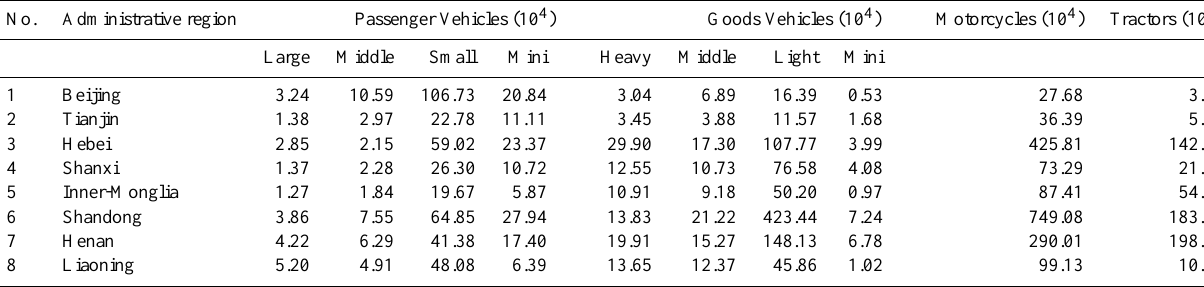
Table 5. Numbers of motor vehicles in the larger Huabei region in 2003.